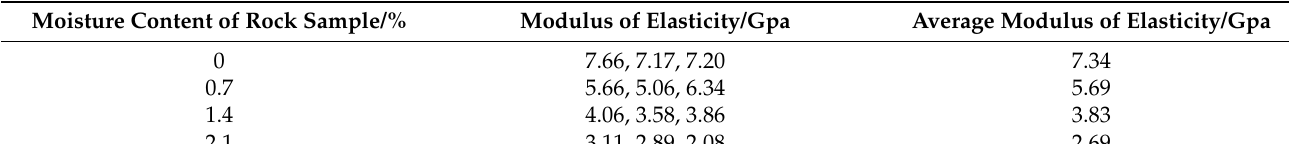
Table 4. Modulus of elasticity of rock samples with different water contents.